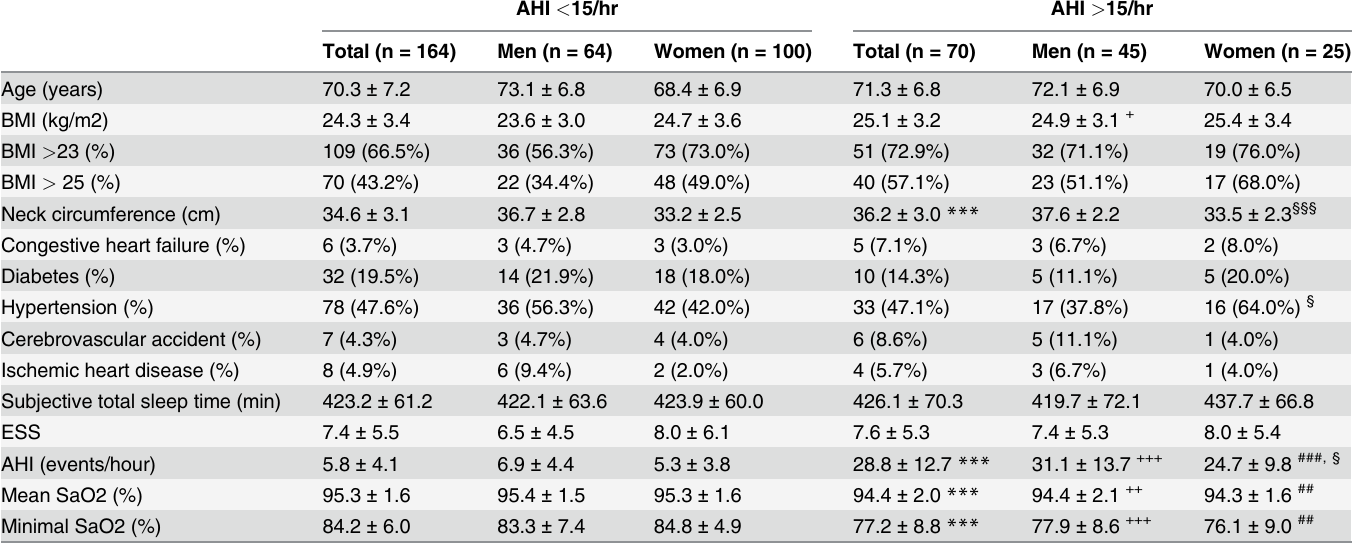
Table 4. Clinical data for the samples (n = 234) with AHI less or equal to versus those with AHI greater than 15 events per hour according to gender (mean ±